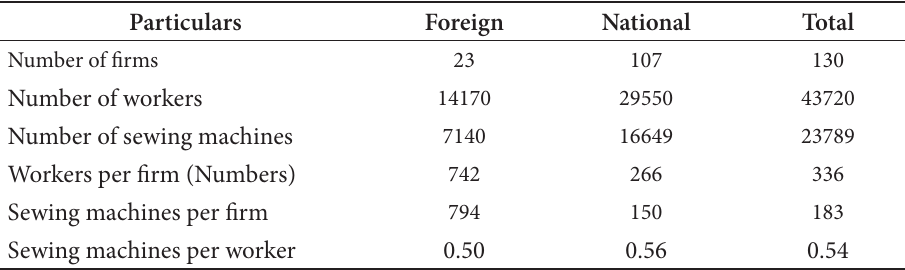
Table 2. Characteristics of firms and capabilities, Garment Industry, Myanmar, 2010